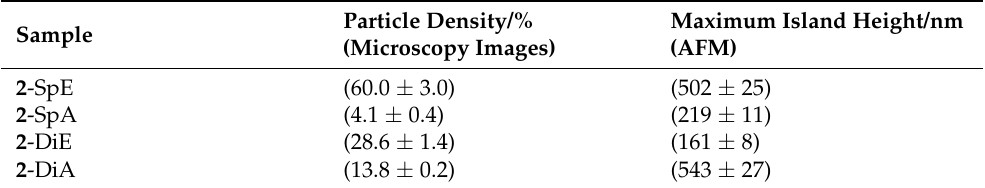
Table 2. Particle densities of the films extracted from the optical microscopy images shown in Figure 8 and maximum height for agglomerations extracted from the AFM images shown in Figure 9. Particle Density/% Maximum Island Height/nm Sample (Microscopy Images)